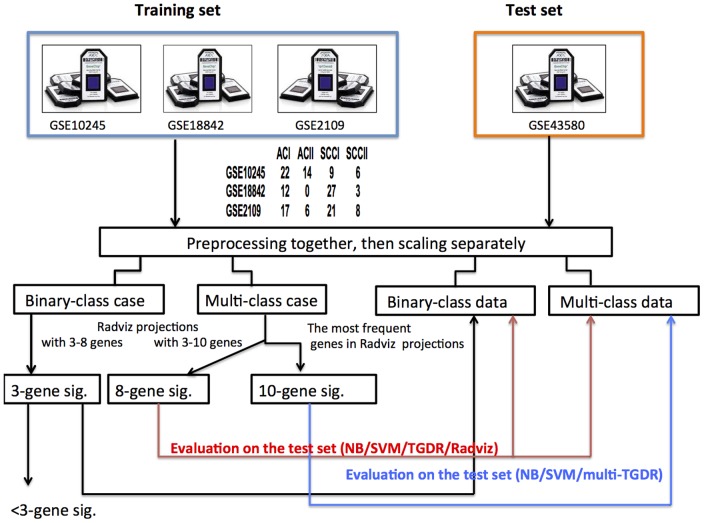
Study flowchart.